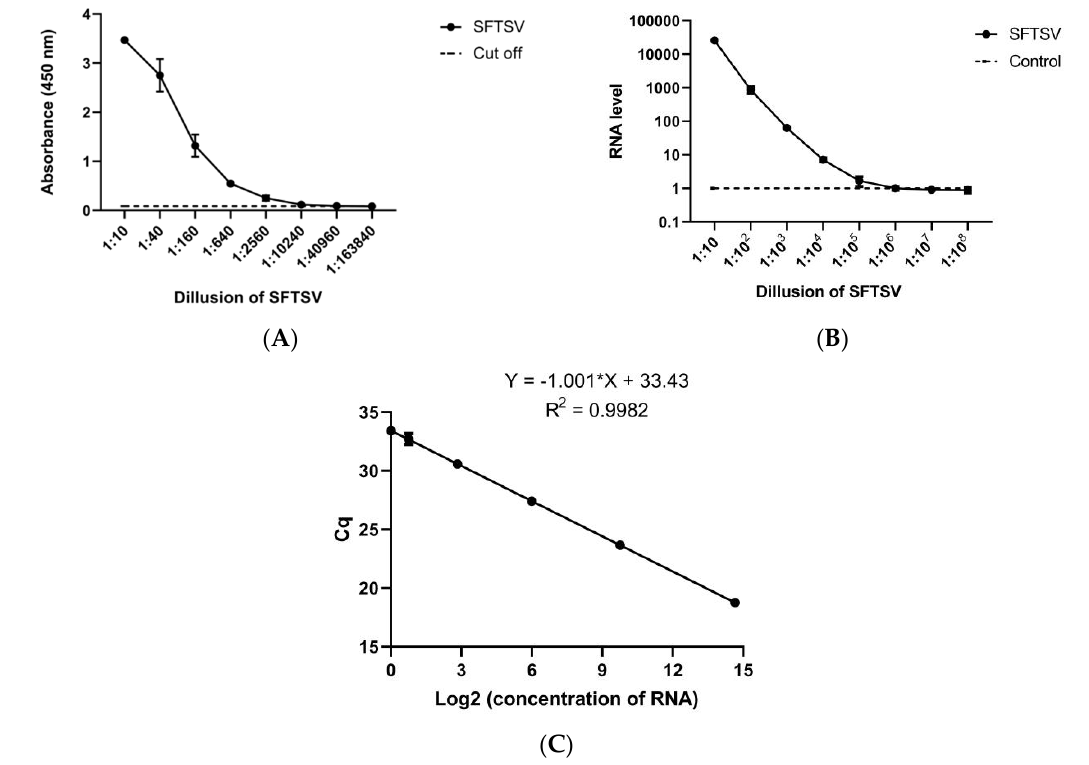
Figure 5. ( A ) Detection of authentic SFTSV via AuNP-based ELISA; qRT-PCR. ( B ) The RNA level corresponding to each dilution. The abscissa is the dilution of cDNA, and the ordinate is the RNA level for each dilution. ( C ) Calibration curve for the quantification cycle [53] (Cq) versus RNA level.